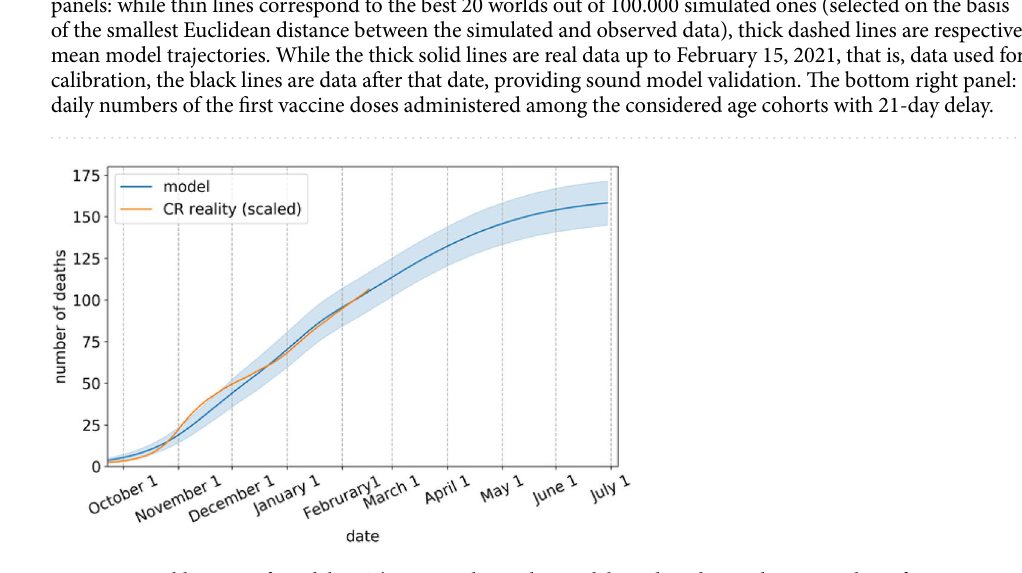
Figure 2. Calibration of Model M. The y -axis shows the model-predicted cumulative number of COVID-19- related deaths in simulation (blue, mean ± one standard deviation) compared to the real situation in the Czech Republic scaled to the model population size